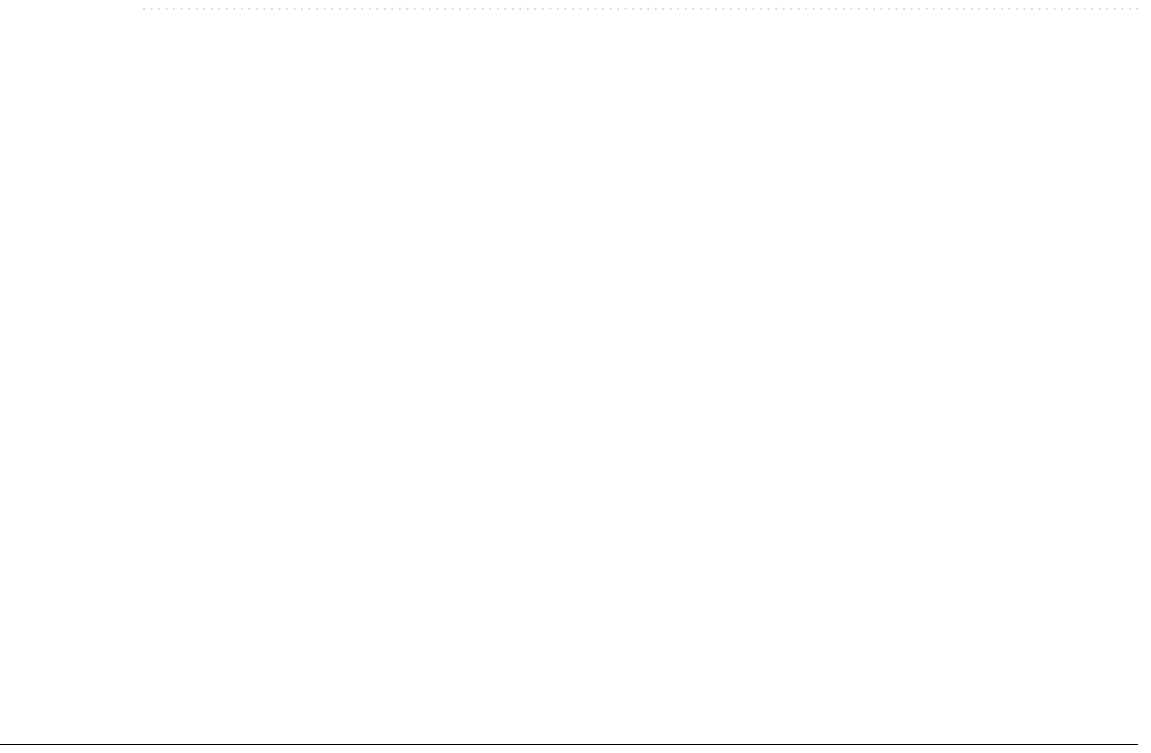
Figure 13. Spider plots of seven performance criteria for prediction of EC using all ML models for Bior6.8 (upper panel) and Dmey (lower panel) in training and testing